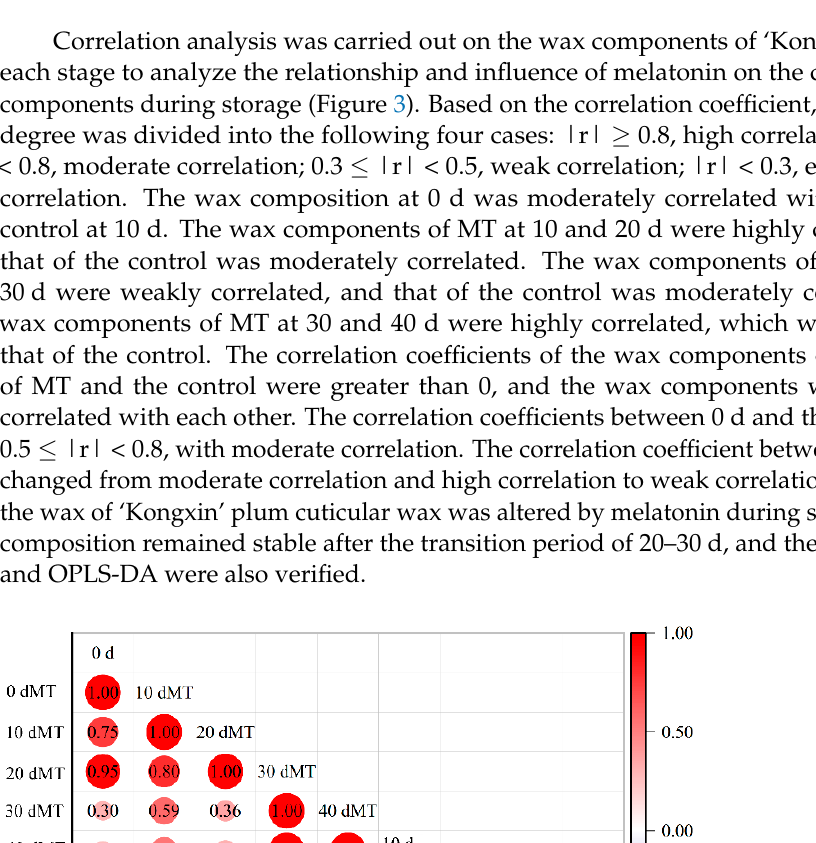
Figure 2. PCA analysis ( A ) and OPLS-DA analysis ( B ) of wax components.